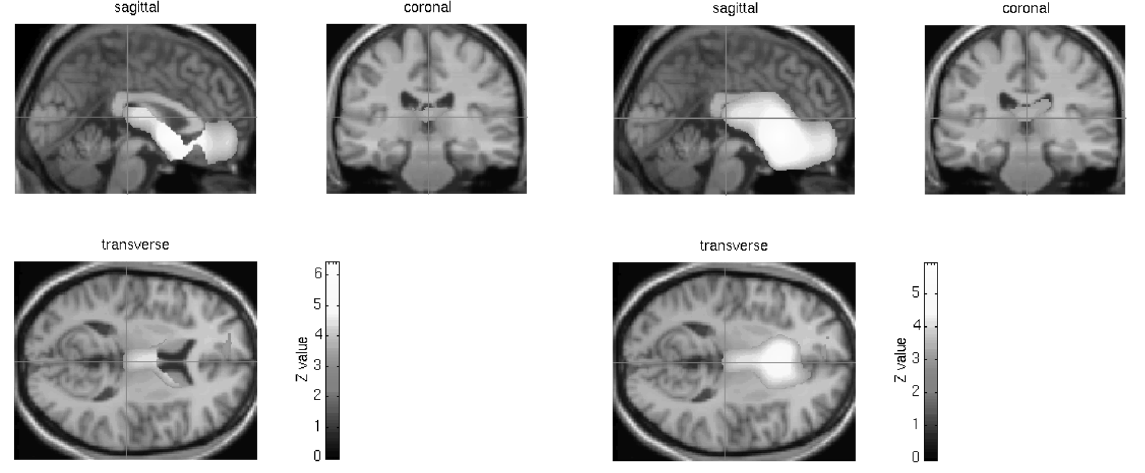
Fig. 5. SPM results comparing ACoA patients with control subjects; Fig. 5(a)(left): whole brain normalisation, Fig. 5(b)(right): cerebellar normalisation. The figures show selected orthogonal slices through the corresponding statistical parametric map superimposed on a standard T1 weighted MR image, which is displayed in Talairach space.